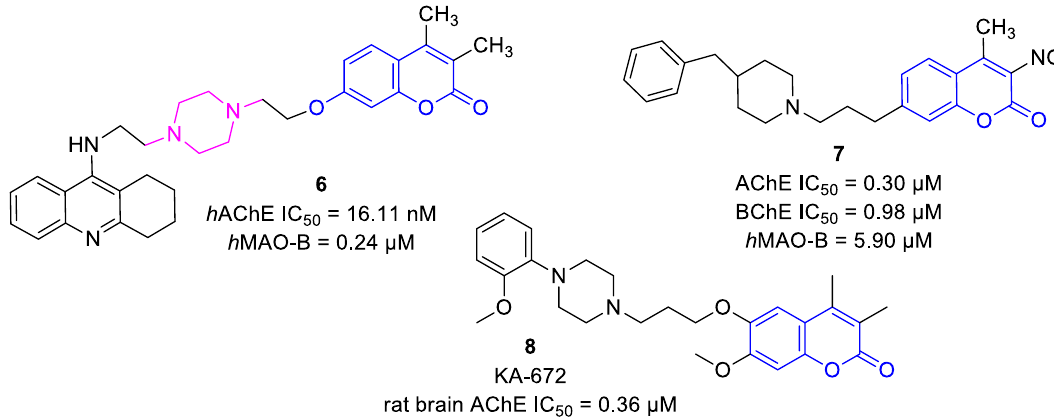
Figure 2. Chemical structure of selected anti-Alzheimer-directed ligands bearing a coumarin moiety 6 – 8 .